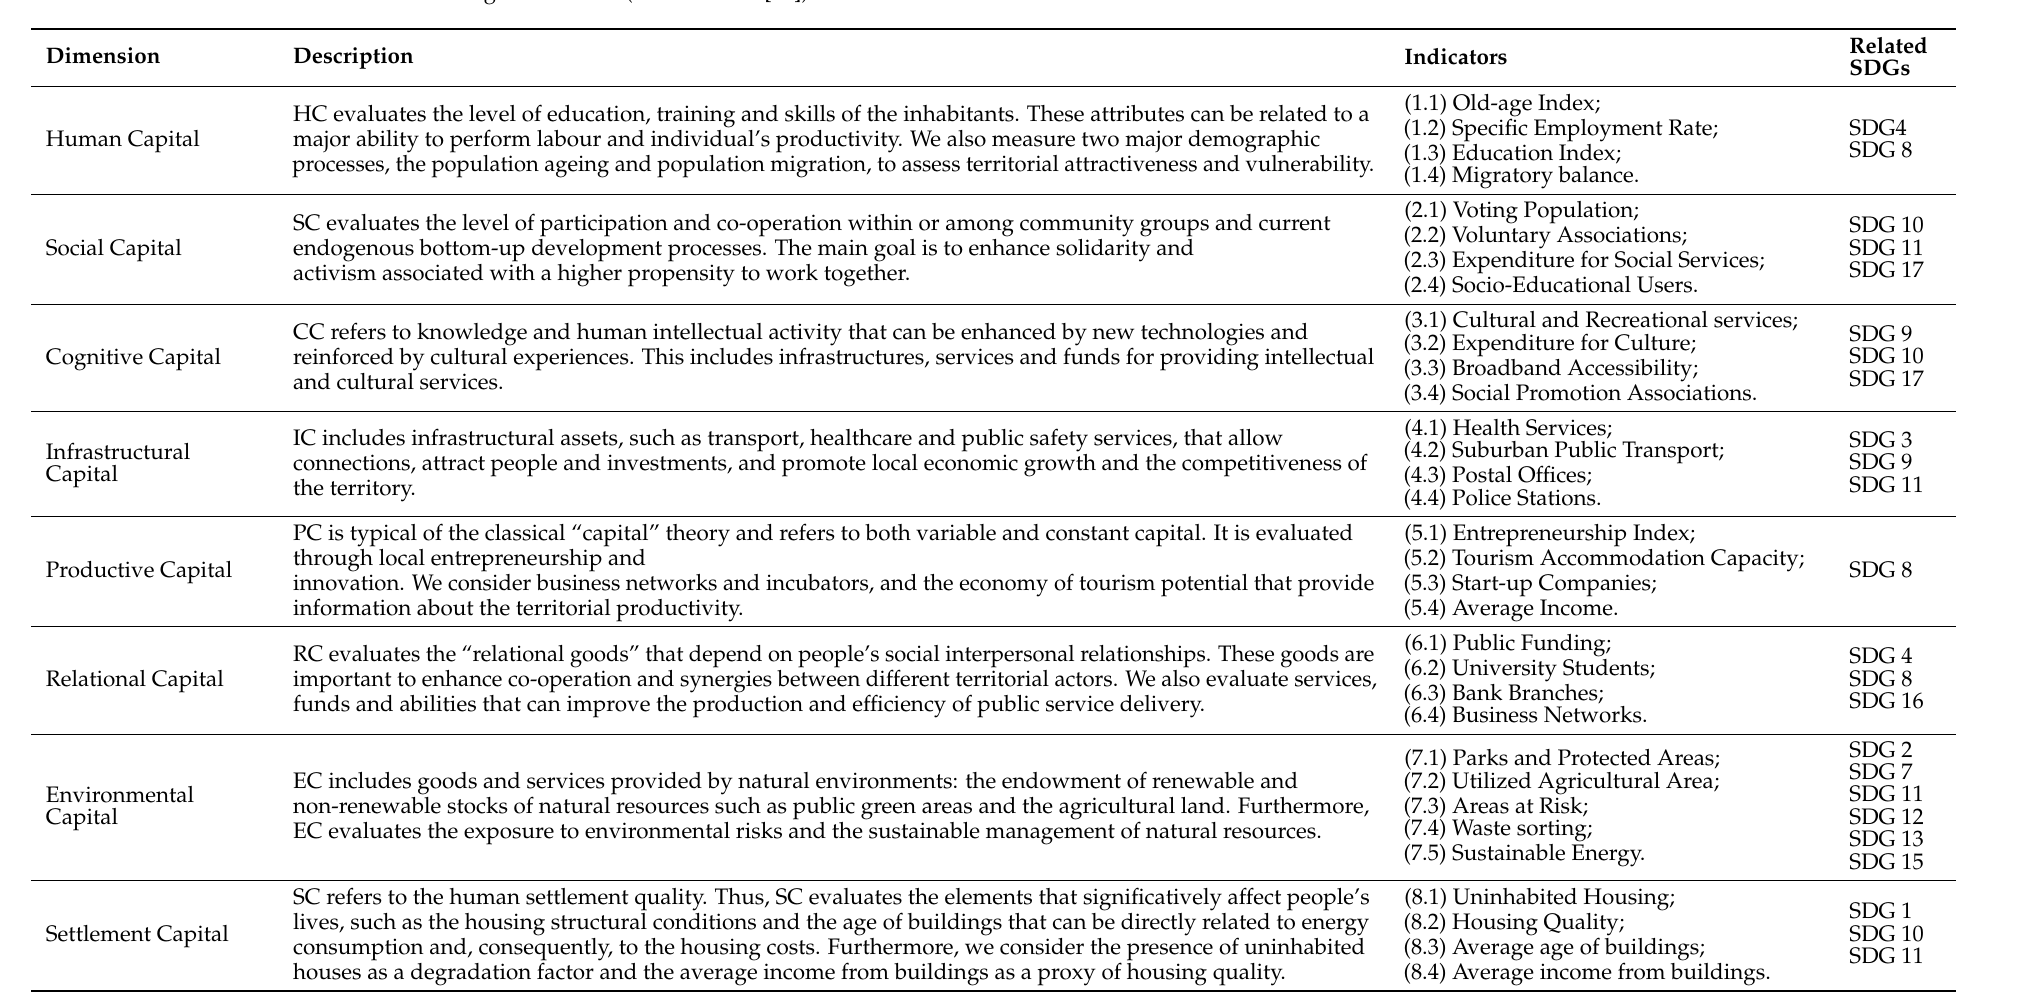
Table 1. The proposed “Territorial Capital Index”, data from: the Italian Statistical Office (ISTAT), the Institute for Environmental Protection and Research (ISPRA), the Italian Ministry of Health, the Italian Ministry of the Interior, the Electrical Services Manager (GSE), the National Third Sector Register (RUNTS) and different Sardinian Regional Offices (revised from